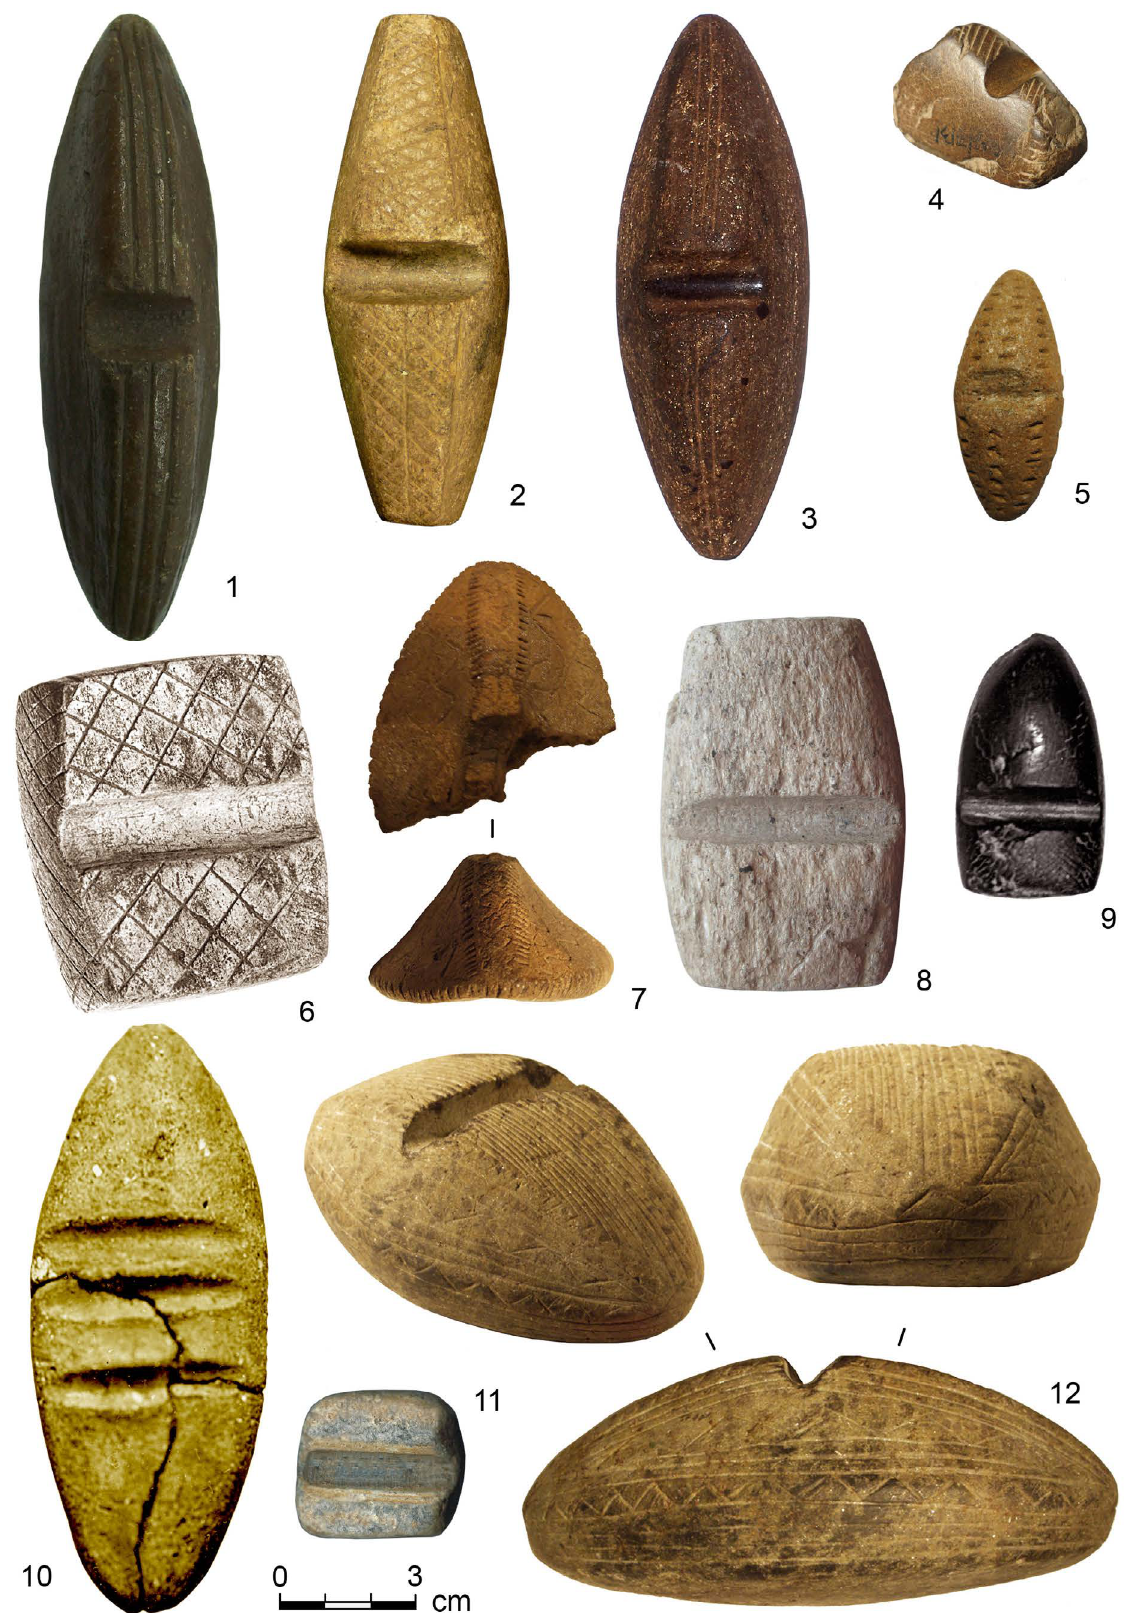
Figure 3. Transverse grooved artefacts from North Eurasia (1, 5, 7, 10 - clay; 2-4, 6, 8-9, 11, 12 - stone). 1, 3, 5, 8, 10 - Middle Urals, Koksharovsky Kholm, Skvortsovskaya Gora-5, Palatki I, Nyazepetrovskaya-2, Koptyaki-9; 2, 7, 12 - Eastern Urals, Kargopolye, Andreyevskaya 1; 4 - Western Siberia, Serebryanka-1; 6 - Southern Urals, Perevozny III; 9 - Altai, Ust’-Isha; 11 - Central Russia, Russko-Shugansky burial